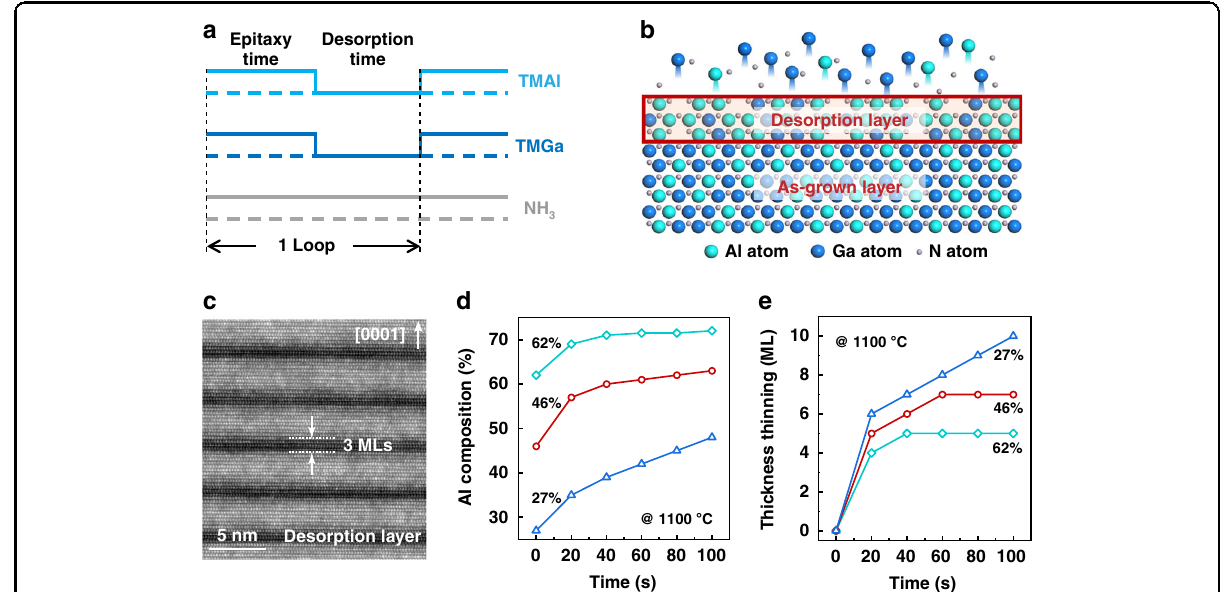
Fig. 1 Schematic process and corresponding structural features of the interrupted epitaxy. a Schematic process of the periodically interrupted epitaxy. b Schematic illustration of the self-assembled bilayer structure by desorption-tailoring. c Z-contrast image of the self-assembled bilayer structures in AlGaN with the desorption time and initial Al composition of 80 s (at 1100 °C) and 46%, respectively. d Desorption time dependence of Al composition in the desorption layer. e Desorption time dependence of the thinning thickness in the as-grown